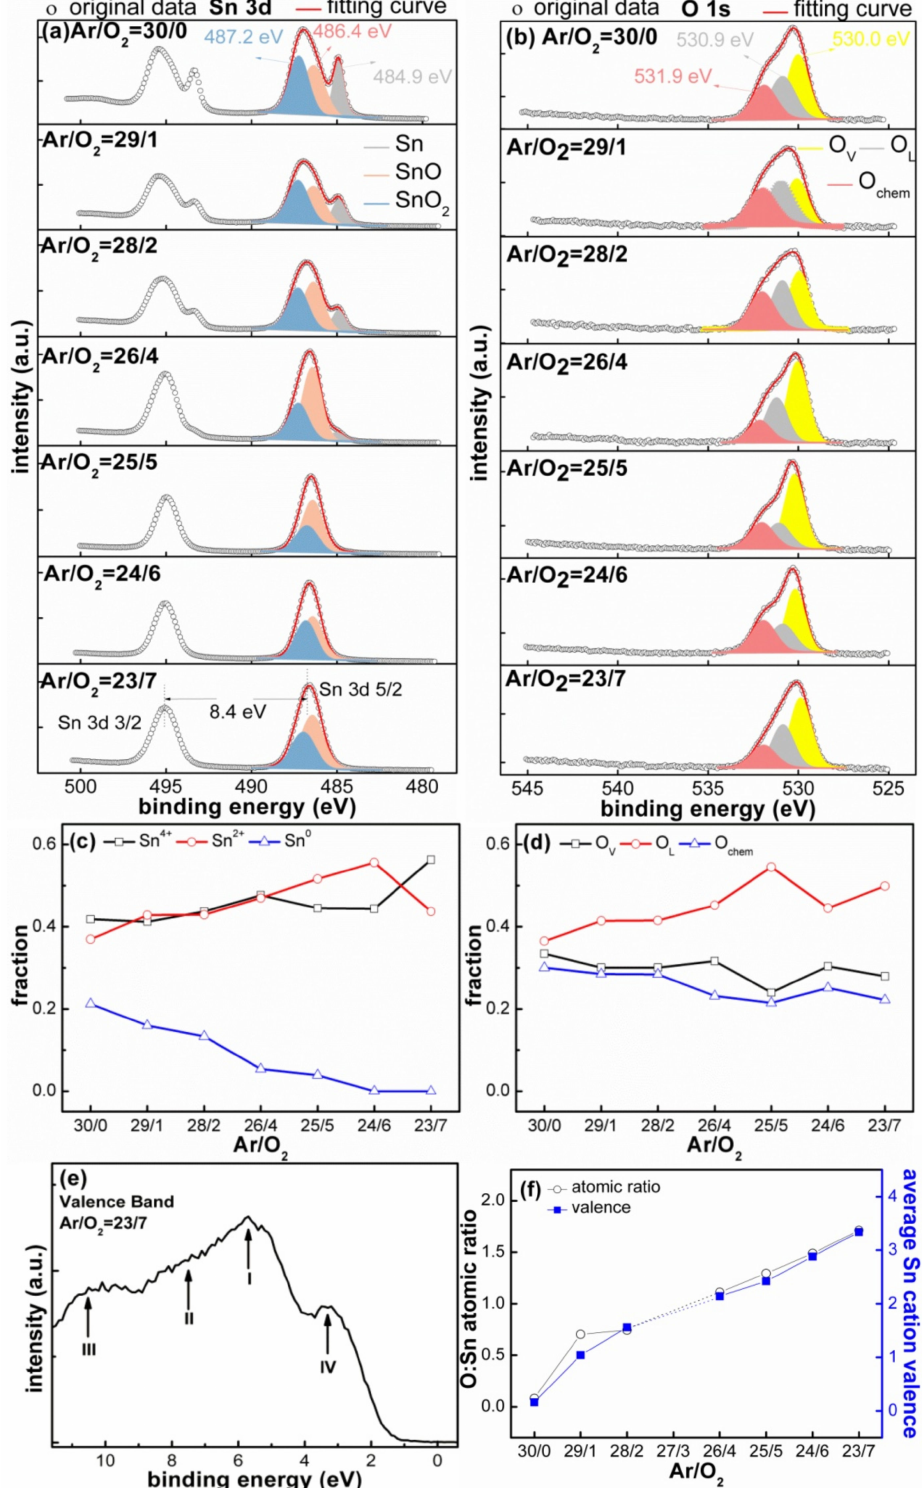
Figure 4. ( a ) Sn 3d and ( b ) O 1s spectra of the SnO x films deposited with different Ar/O 2 flow ratios; the relative content of ( c ) Sn and ( d ) O with increased O 2 flow ratios; ( e ) valence band spectrum; ( f ) summary of the O:Sn atomic ratios and average Sn cation